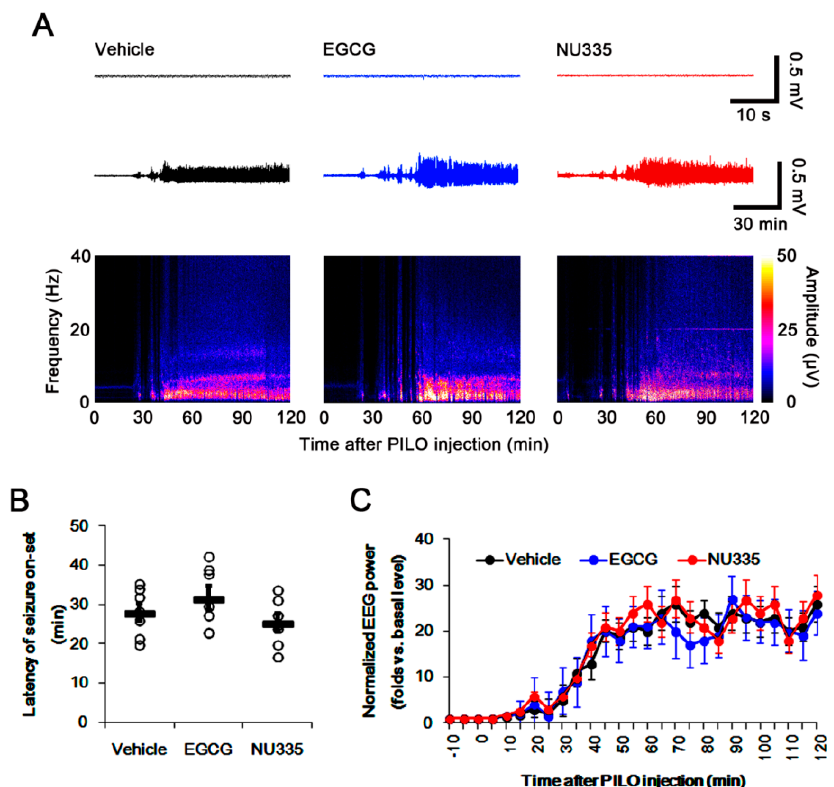
Figure 1. Effects of epigallocatechin-3- O -gallate (EGCG) and NU335 on seizure activity in response to pilocarpine. Neither EGCG nor NU335 affects seizure activity and seizure threshold in response to pilocarpine. ( A ) Representative baseline electroencephalogram (EEG) (upper traces), seizure activity (lower traces), and frequency-power spectral temporal maps in response to pilocarpine. ( B ) Quantification of latency of seizure onset in response to pilocarpine ( n = 7, respectively). Open circles indicate each individual value. Horizontal bars indicate mean value. Error bars indicate S.E.M. ( C ) Quantification of total EEG power (seizure intensity) in response to pilocarpine ( n = 7, respectively). Error bars indicate S.E.M.